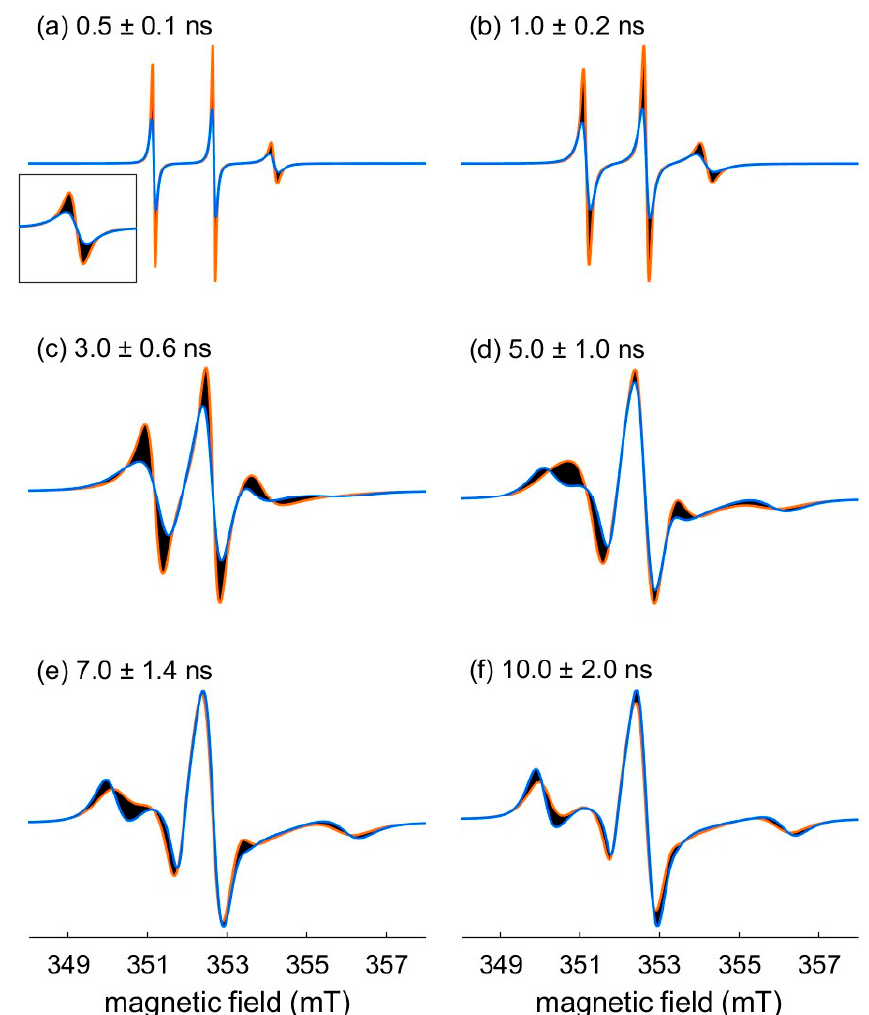
Figure 2. Influence of a relative variation (20%) of t corr on the nitroxide X-band cw EPR spectral shape for: ( a ) t corr = 0.5 ns; ( b ) t corr = 1 ns; ( c ) t corr = 3 ns; ( d ) t corr = 5 ns; ( e ) t corr = 7 ns; ( f ) t corr = 10 ns. Each panel is the superosition of 100 simulated spectra (black traces) with a correlation time ranging from 0.8*t corr to 1.2*t corr . The traces for the minimal and the maximal considered t corr are orange and blue, respectively. Inset in panel ( a ): zoom of the low field line. All the spectra are normalized to their integrated intensity. Parameters for the simulations: g x = 2.0084, g y = 2.0061, g z = 2.0022, A xy = 0.45 mT = 12.6 MHz, A z = 3.66 mT = 102.6 MHz, at 9.9 GHz, no additional broadening.